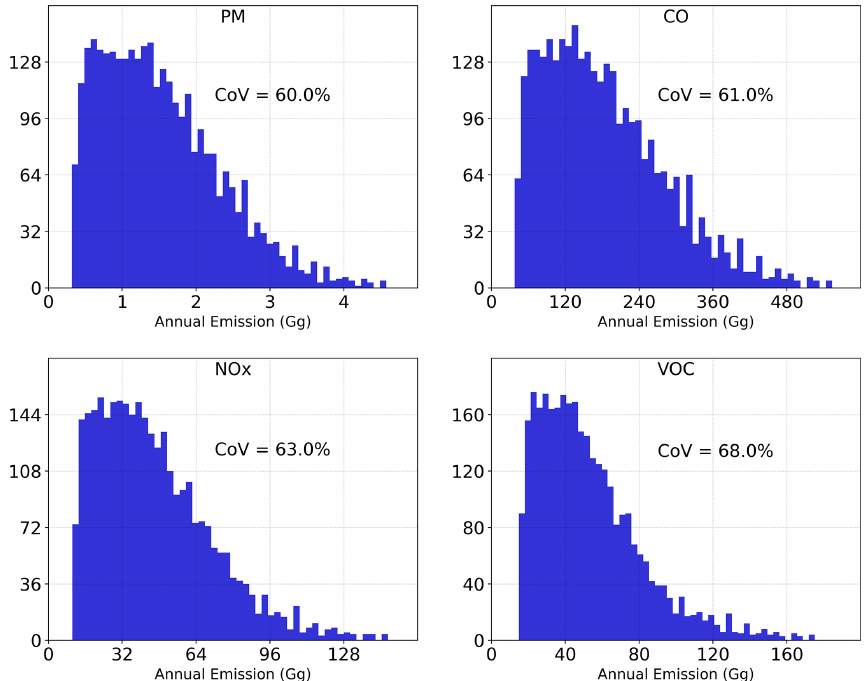
Figure 6. Histogram showing the variation in the annual emissions with the combination of sensitive parameters (VKT and EF).